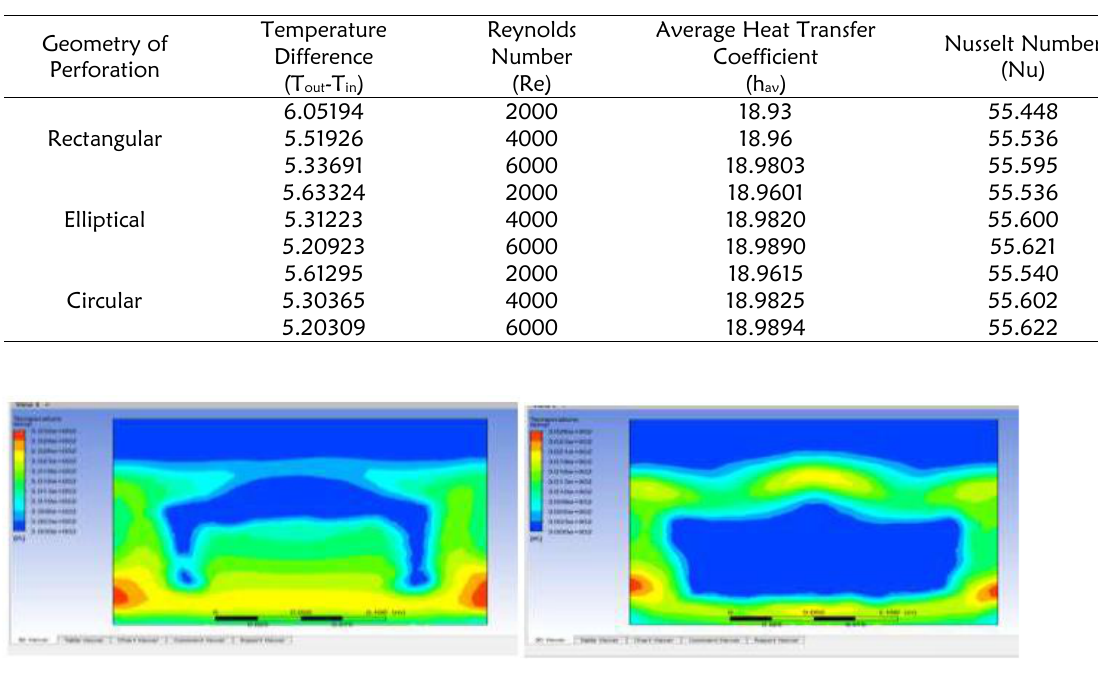
Figure 9: Temperature distribution at outlet for rectangular shape and elliptical shape [71]